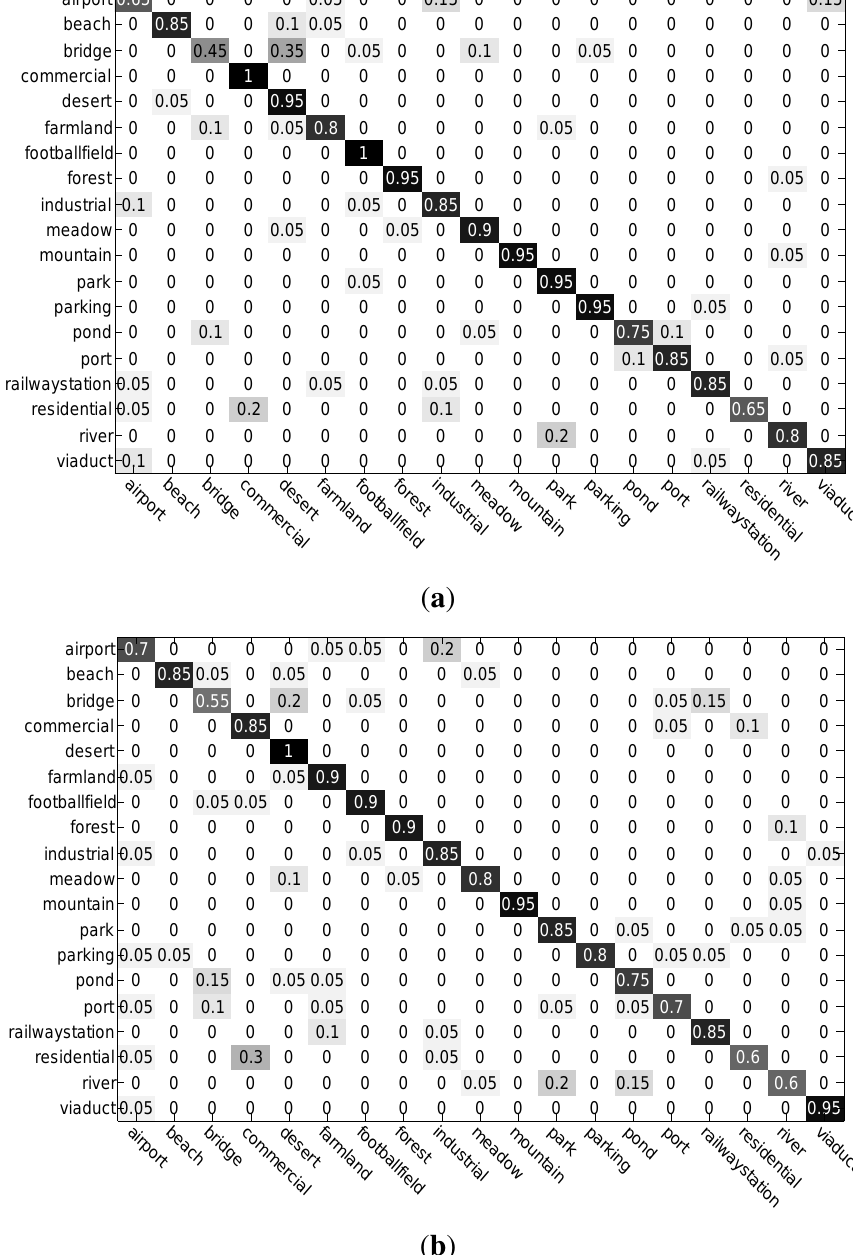
Figure 12. Comparisons of the confusion matrices using random sampling ( a ) and the RCS sampling ( b ) method on the RS19 dataset when the sampling ratio is equal to 0 . 2